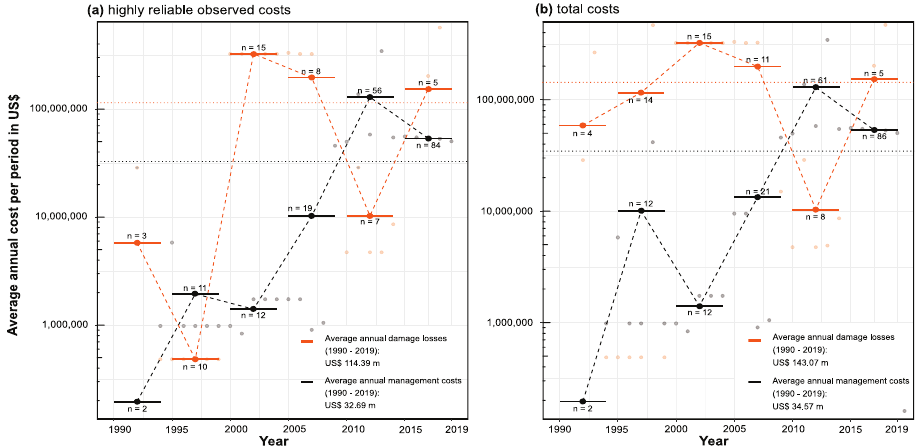
Figure 4. Temporal trends using a robust cost estimates (reliable and observed costs) and b total cost estimates, in management costs (black) and damage costs (brown) from 1990 to 2019. Periodic averages are presented on a log scale. Points represent annual totals. Numbers indicate annualized cost entries per 10 5-year